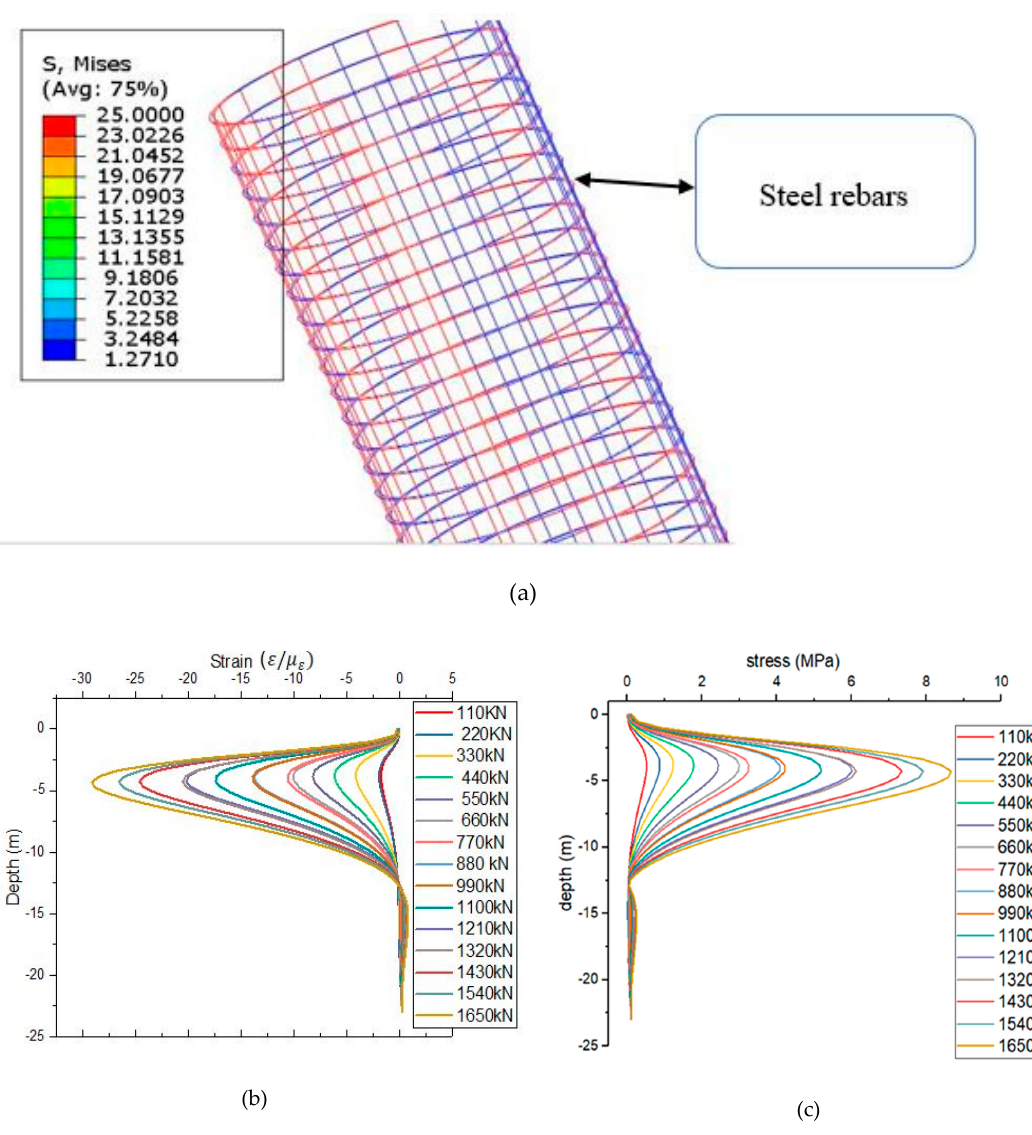
Figure 12. Stress and strain of a lateral load of steel along the pile; ( a ) the steel bar modeling; ( b ) the strain of lateral of steel along the pile; ( c ) the stress of lateral of steel along the pile.